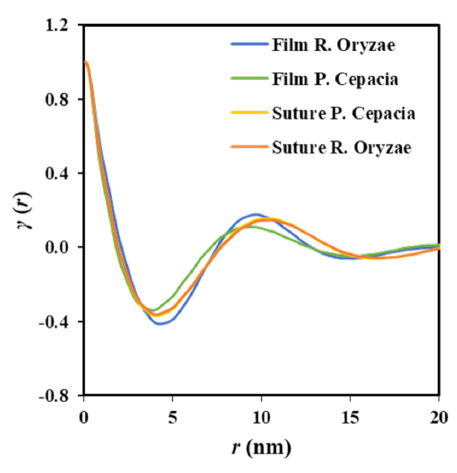
Figure 11. Correlation function of the SAXS peak determined for P4HB films and sutures exposed to Pseudomonas cepacia and Rhizopus oryzae media at 37 °C for 14 days.